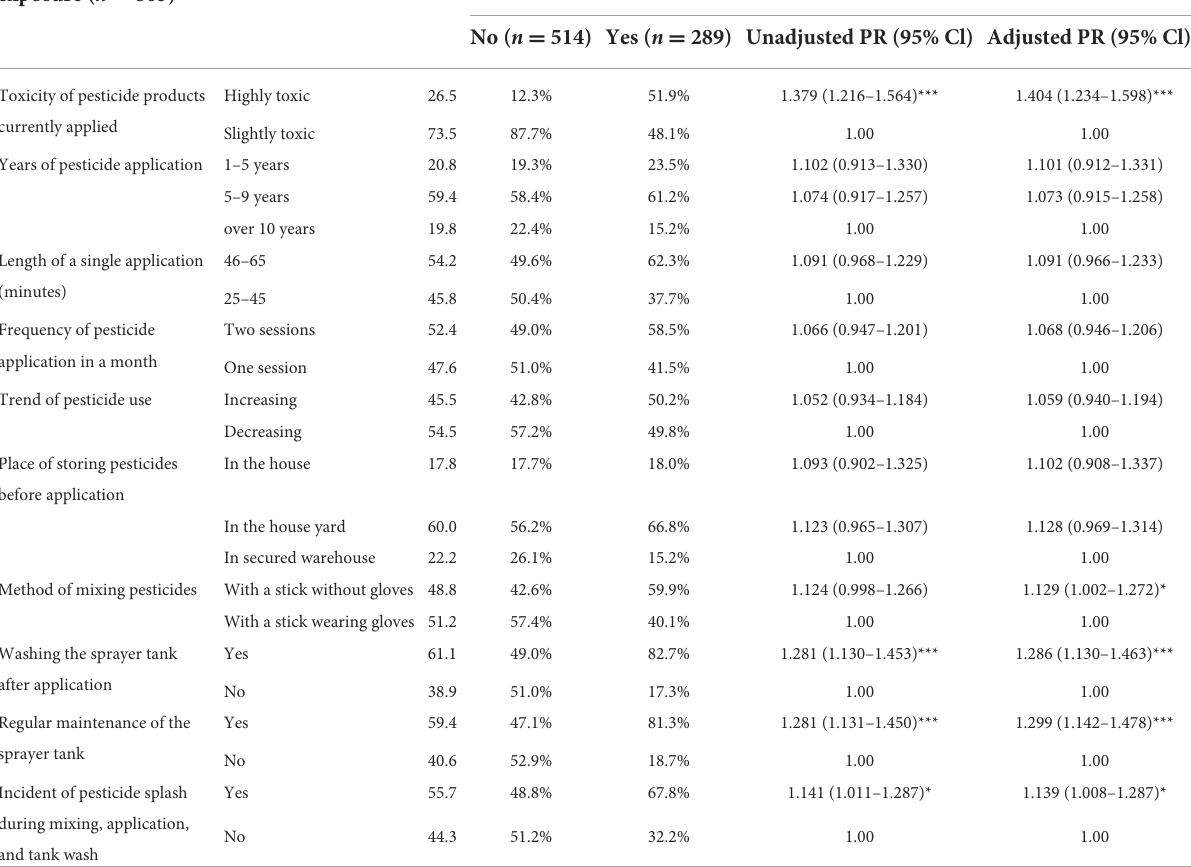
TABLE 9 Association between pesticide use and exposure, and health effects among pesticide applicators in East Hararge Zone, Oromiya Region, Ethiopia. Pesticide use and exposure ( n =